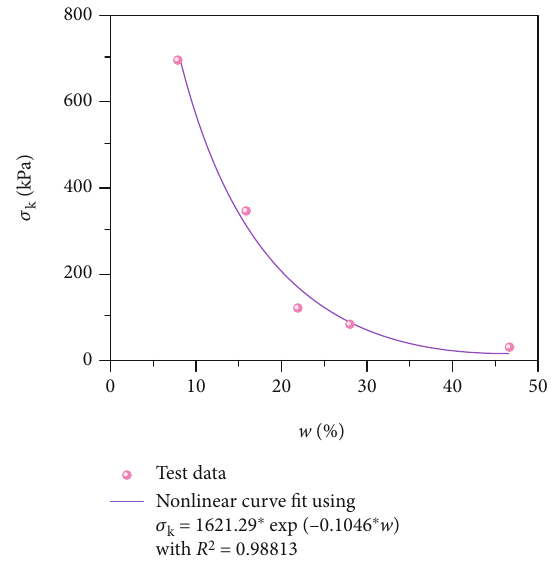
Figure 5: Relation between structural yield stress and moisture content for undisturbed